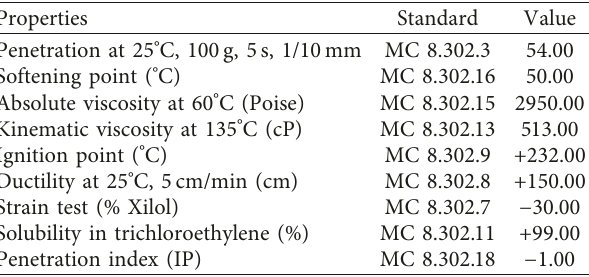
Figure 1: Gradation curves (IV-A-12). Table 1: Specifications of the asphalt binder CA-24.